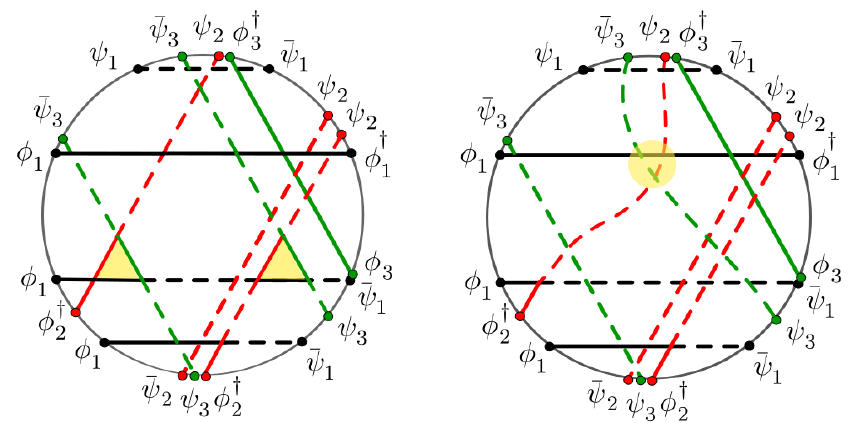
Figure 5 . Other possible planar graphs for the same 20-point function of (cid:12)gure 4 at order (cid:24) 48 . On the left, the yellow triangles have di(cid:11)erent edges w.r.t. (cid:12)gure 4. On the right, one red-dashed